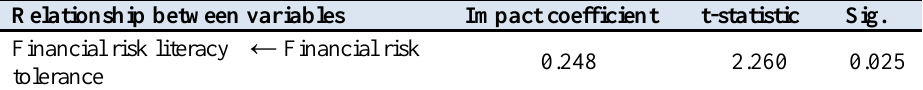
Table 8: Estimation of the coefficients of the fifth